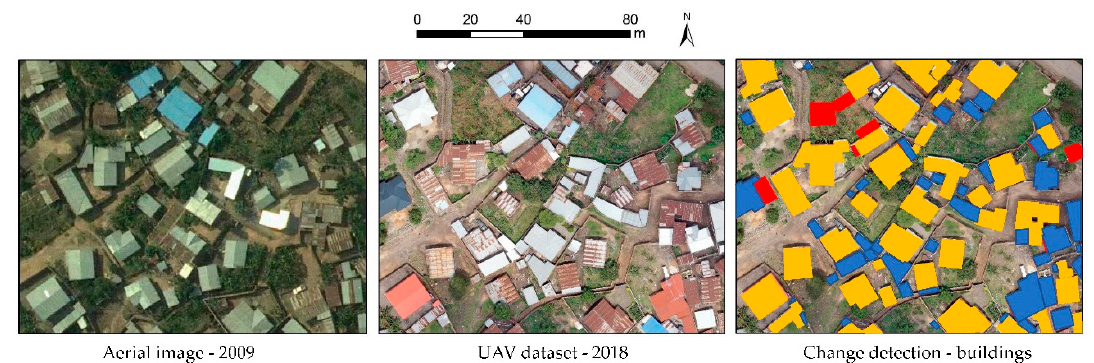
Figure 7. Left: Orthomosaic based on aerial images from 2009; centre: Orthomosaic based on UAS images from 2018; right: Change detection of buildings (orange: buildings remained the same, red: buildings got demolished, blue: new building constructions).